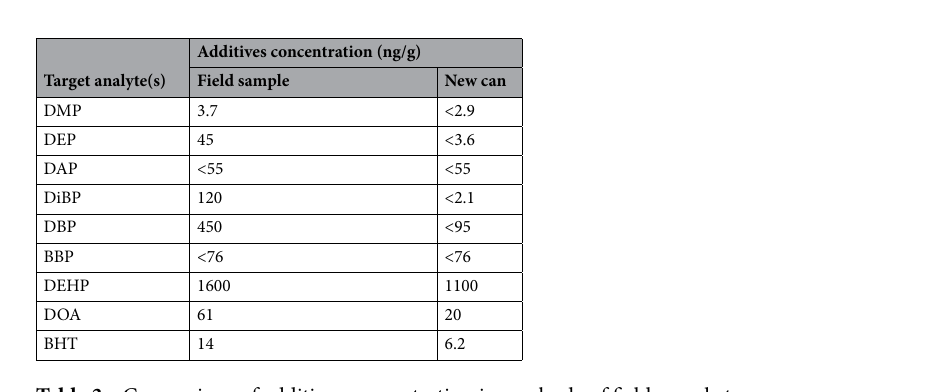
Table 3. Comparison of additives concentration in can body of field sample to new